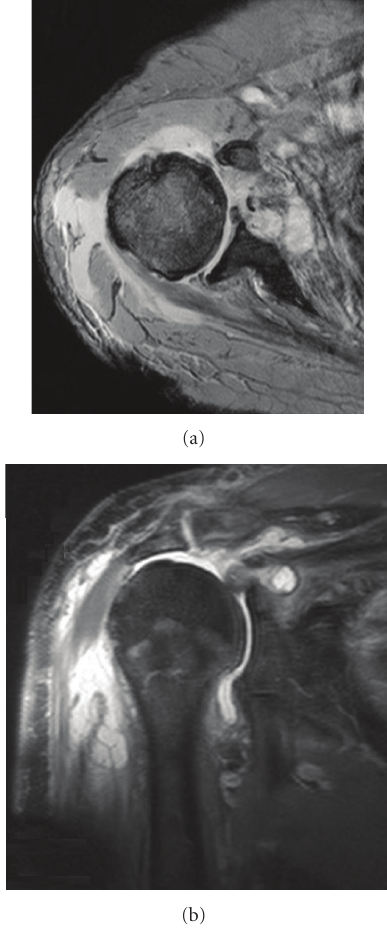
Figure 2: T2 Weighted MRI Images of the right shoulder taken at 22 hours after presentation, showing early osteomyelitis, bone marrow oedema, bursal collection, and high signal consistent with septic arthritis.